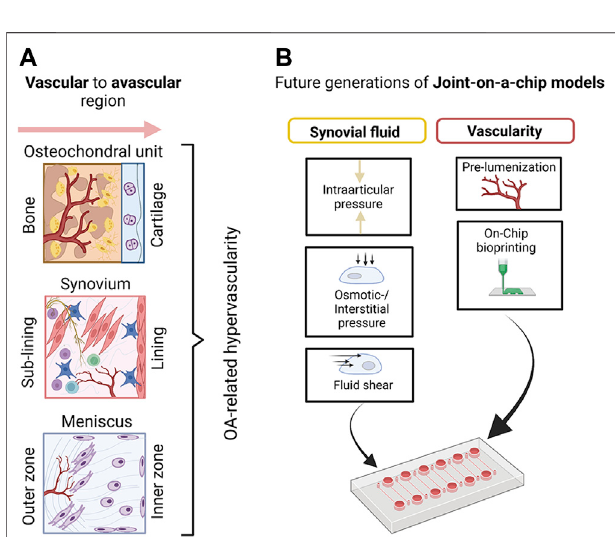
FIGURE 11 | (A) A schematic overview of basic vascular transitions within musculoskeletal tissues which are affected by OA-related hypervascularization. (B) A proposed future strategy to model joint tissue- speci fi ctransitionswithbiomimeticvascularizedjoint-on-a-chipsystems includes the creation of vascular blueprints/templates with bioprinting as well as the provision of more relevant bio fl uid properties (e.g., viscoelasticity of blood and synovial fl uid surrogates) and fl uid-dependent biomechanical principles including fl uid interstitial, as well as intra-arcticular pressure. Created with permissions from